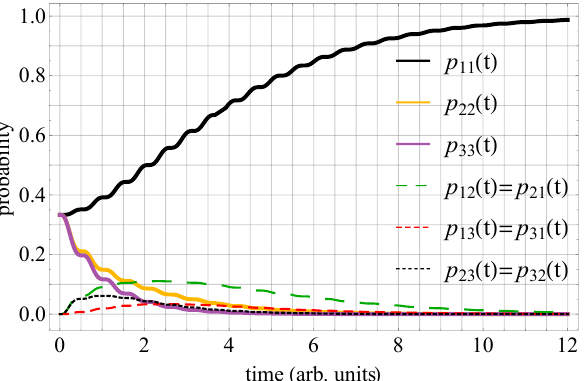
Figure 11. Plots present the probability of finding a two-qutrit system in one of the possible states. The initial state is represented by (33).